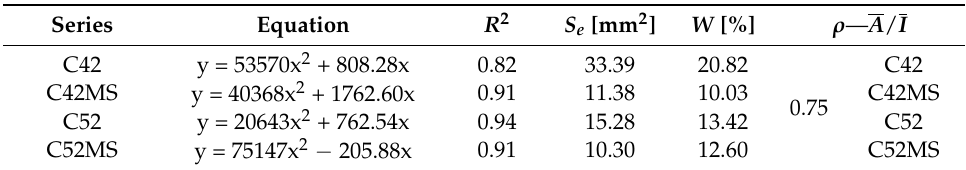
(cid:0) (cid:1) I relationship, together with values of diagnostic